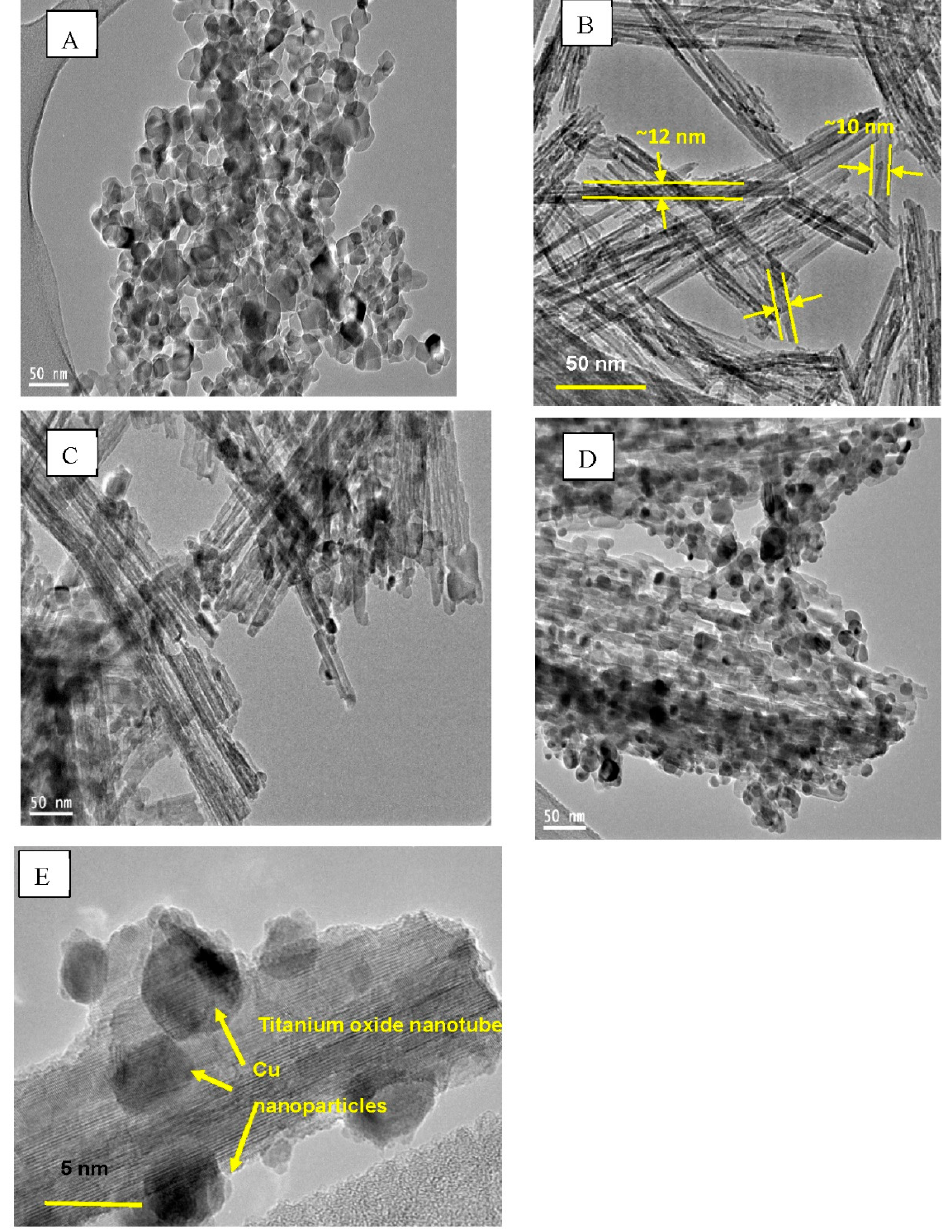
Figure 3. TEM images for ( A ) Degussa (P-25), ( B ) pristine TNT, ( C ) 5% Cu/TNT, ( D ) 20% Cu/TNT, and ( E ) high-resolution TEM image for 20% Cu/TNT.